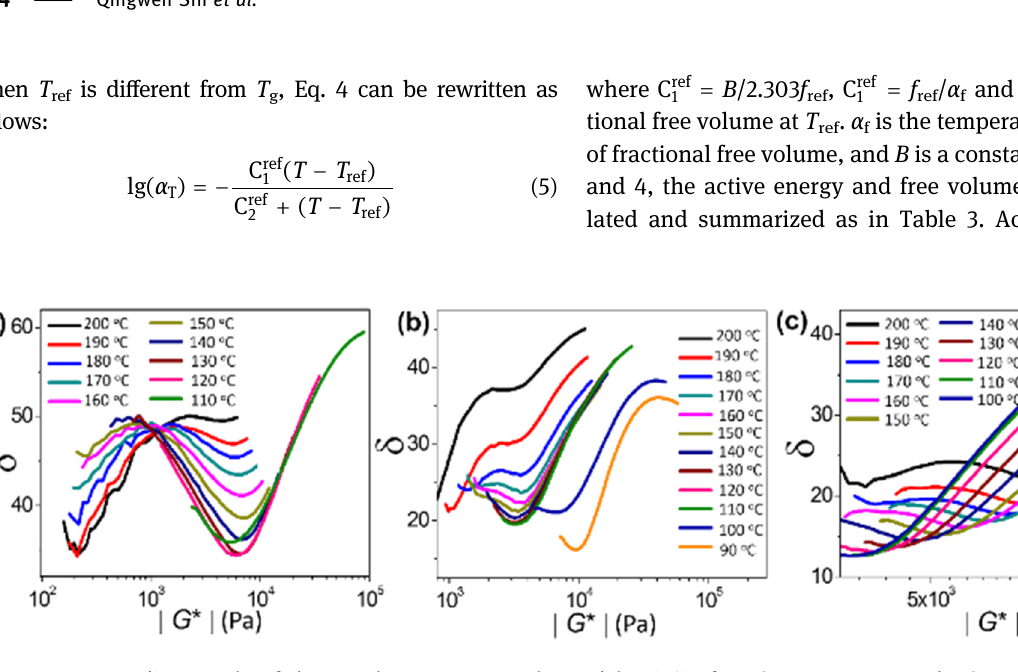
Figure 2: Corresponding vGP plot of phase angle ( δ ) versus complex modulus (| G * |) of ( a ) ( S 15.4 - 0.48 - B 16.7 ) 3 , ( b ) ( S 15.4 - 0.28 - B 34.3 ) 3 , and